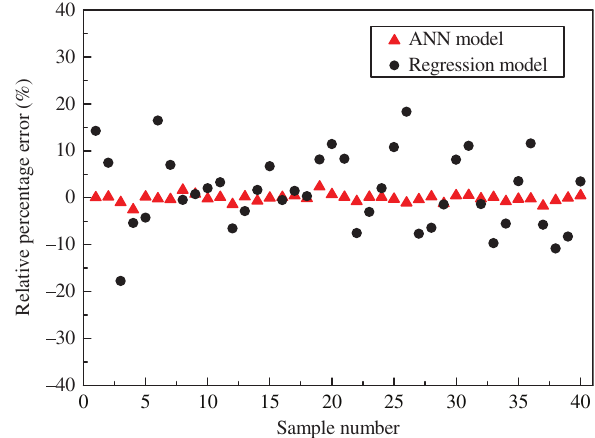
Figure 14 Correlation between experimental and predicted flow stress by ANN model at strain of 0.5